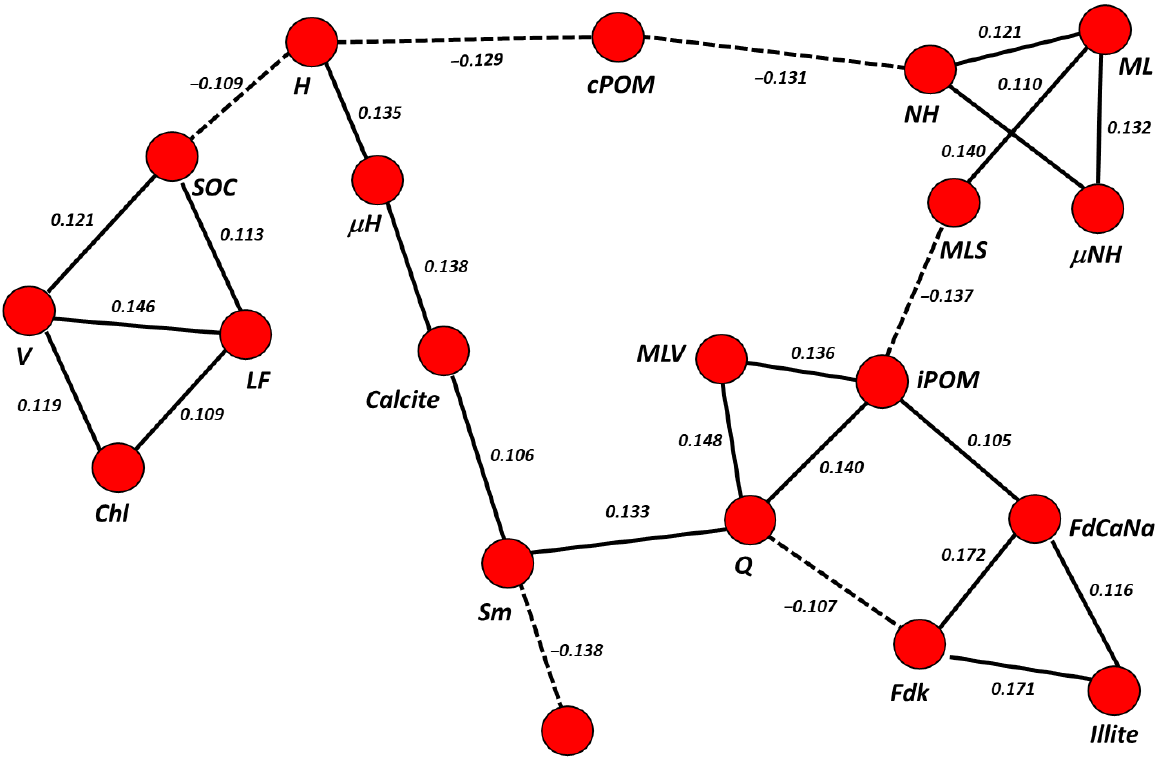
Figure 8. PCN between SOC pool subfractions and soil clay minerals at p < 0.05 and false discovery rate < 0.25. Dashed lines: negative correlations. (For abbreviations, see Tables 2 – 5).